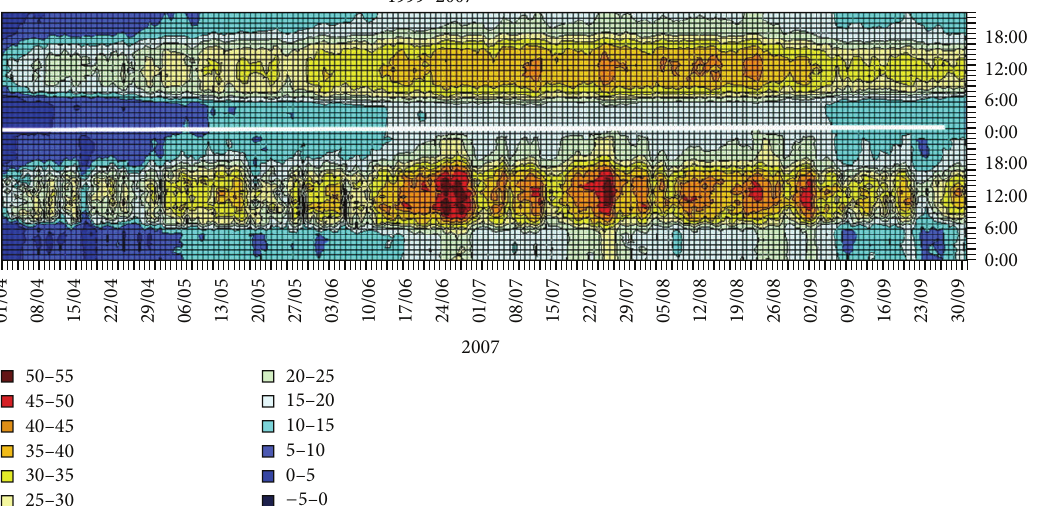
Figure 5: Composite mean hourly variability of PET within the warm period 1999–2007 (upper graph), along with the hourly variability of PET within the warm period 2007 (lower